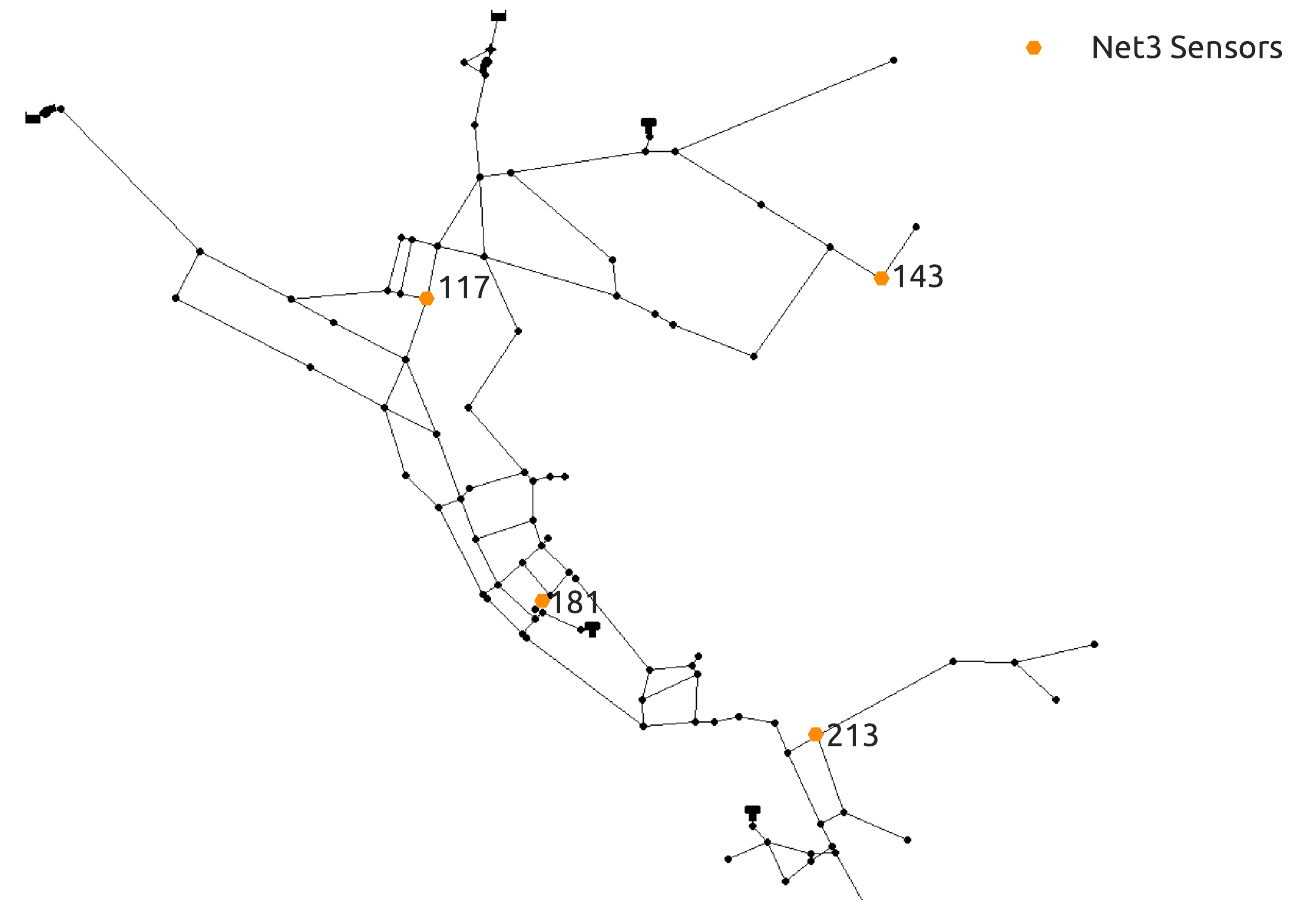
Figure 1. NET3 water distribution network benchmark with sensor